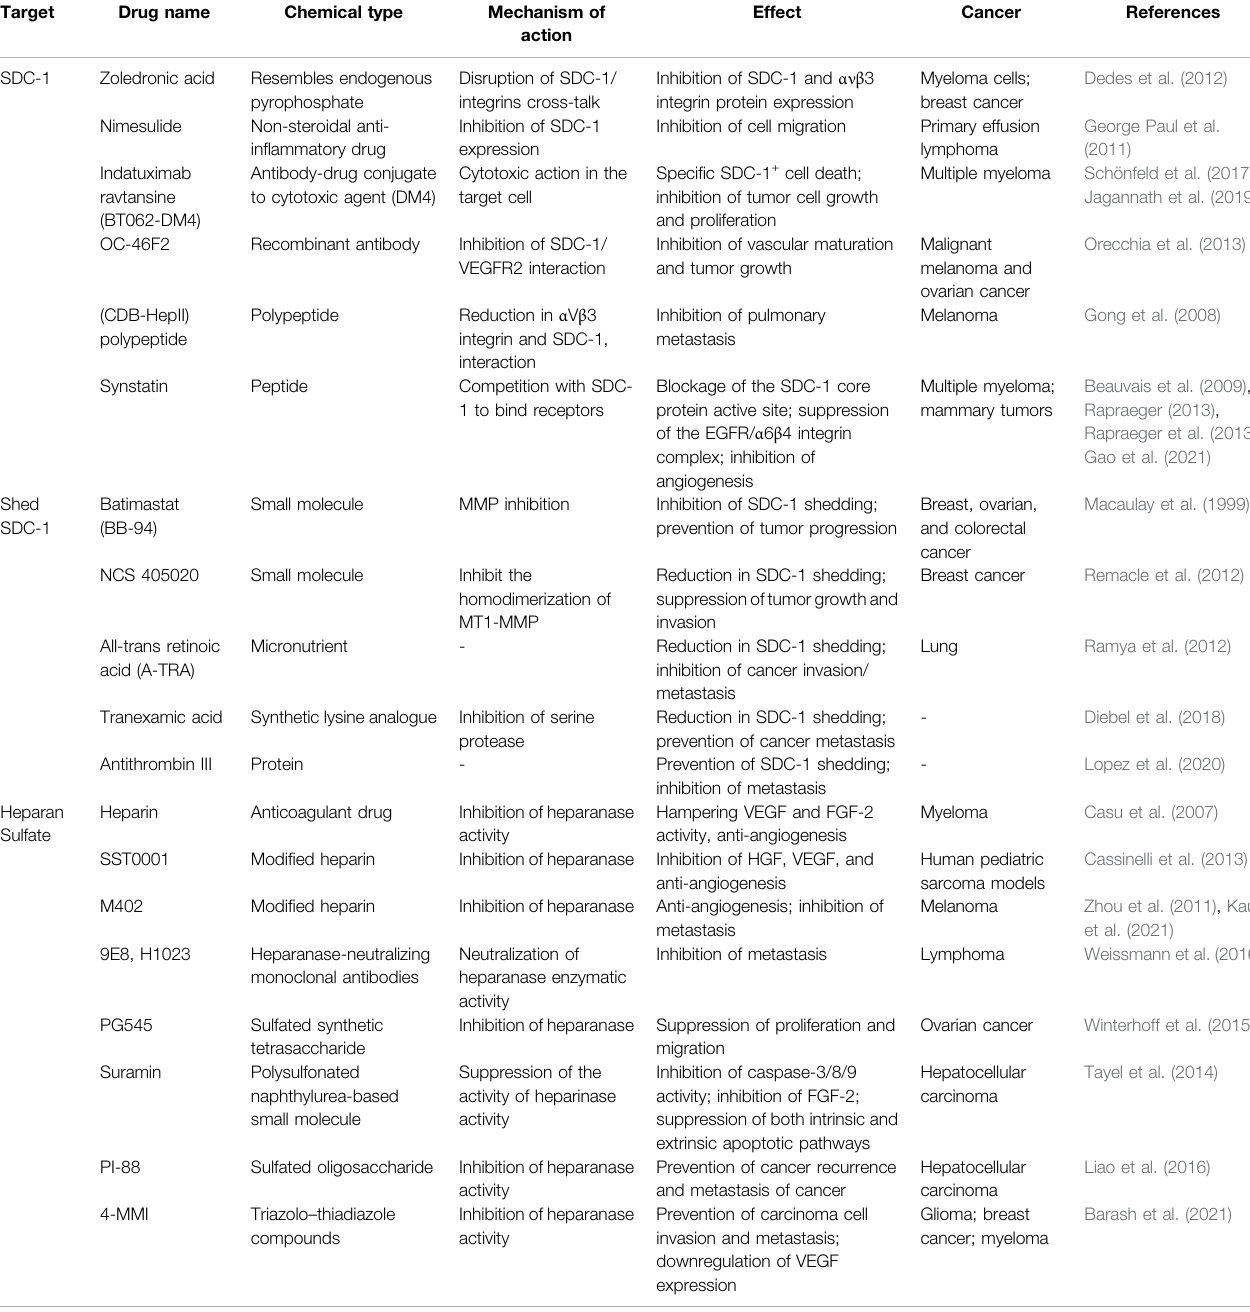
TABLE 1 | Drugs targeting SDC-1 or SDC-1-related